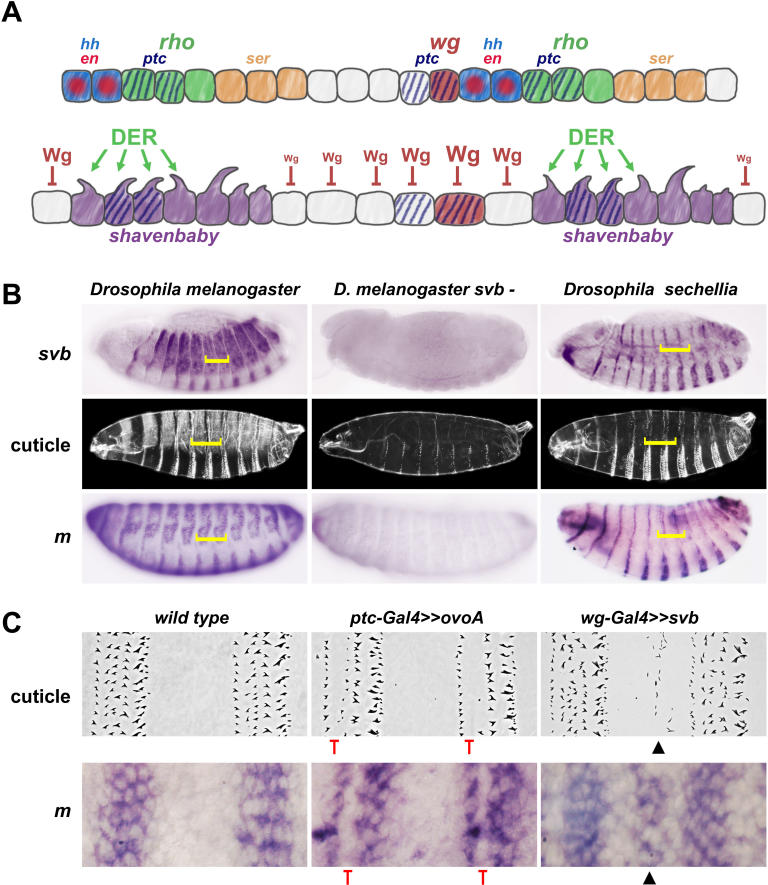
Control of m Expression by svb in the Embryonic Epidermis(A) Schematic representation of the signaling pathways that control morphological differentiation of the ventral embryonic epidermis, at stage 12 (top) and at the end of embryogenesis (bottom); anterior is to the left. In addition to engrailed (en), posterior cells express Hedgehog (Hh), and patched (ptc) is expressed in a two-cell-wide stripe on each side of the Hh-expressing cells. Hh, together with serrate (Ser), activates rhomboid (Rho) expression in a three-cell wide stripe. The Rhomboid protease activates the ligand of the d-EGF receptor (DER), whose activation triggers the expression of svb, resulting in the formation of six to seven rows of denticles. Wingless, which is expressed in the posterior-most row of anterior cells, diffuses asymmetrically and represses shavenbaby transcription to form naked cuticle.(B) Whole-mount in situ hybridization of svb (top) and m (bottom) mRNA; cuticles are shown in the middle panels. Inactivation of svb prevents the formation of most trichomes and abolishes m epidermal expression. m expression foreshadows the pattern of trichomes in D. melanogaster and D. sechellia larvae. Yellow brackets outline two dorsal segments.(C) Close-up of the cuticle region corresponding to the third (A3) and fourth (A4) abdominal segments (top) and m mRNA distribution (bottom), in wild-type D. melanogaster embryos (left), ptc-Gal4-driven expression of UAS-OvoA (middle) and expression of UAS-svb under the control of wg-Gal4 (right). Whereas in wild type, m is expressed in each segment in a five to seven–cell-wide stripe, the expression of OvoA prevents the formation of denticle rows 2–3 and represses m expression in the corresponding cells (red lines). Reciprocally, ectopic expression of svb in wg cells triggers the formation of supernumerary denticles and ectopic expression of m (arrowheads).